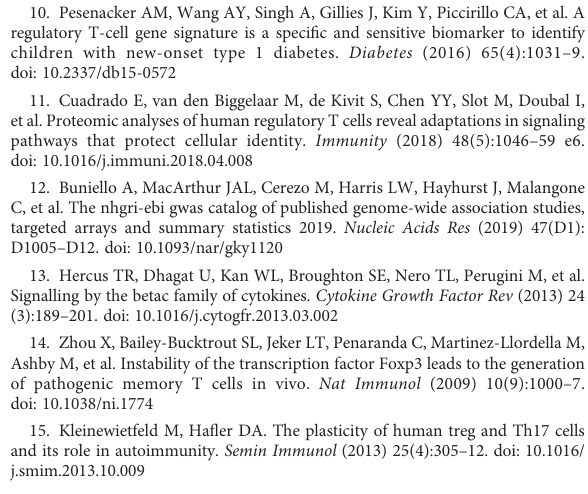
SUPPLEMENTARY FIGURE 1 Phenotype of FACS-sorted CD4 + Tconv and Tregs. Representative reanalysis of CD4, CD25, CD127 and FOXP3 phenotype of peripheral blood isolated CD4 + Tconv and Tregs. SUPPLEMENTARY FIGURE 2 CSF2RB epigenetic and transcriptomic signature. (A) Epigenetic signature at the CSF2RB locus was studied using WashU epigenome browser (v52.1.0) (27). Data from human CD4 + CD25 - Th and CD4 + CD25 + CD127 - Treg primary cells obtained from blood of healthy donors were downloaded from the Roadmap Epigenomics Project (26, 45). CSF2RB